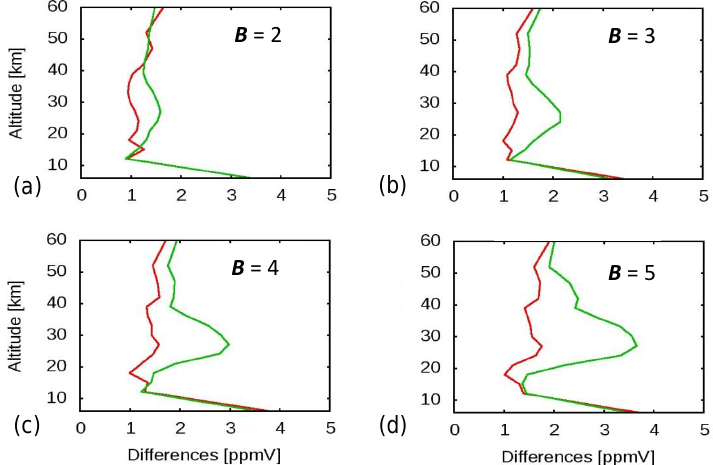
Figure 6. As Fig. 5 but in the case of B = 3 for the P - and B = 4 for the T